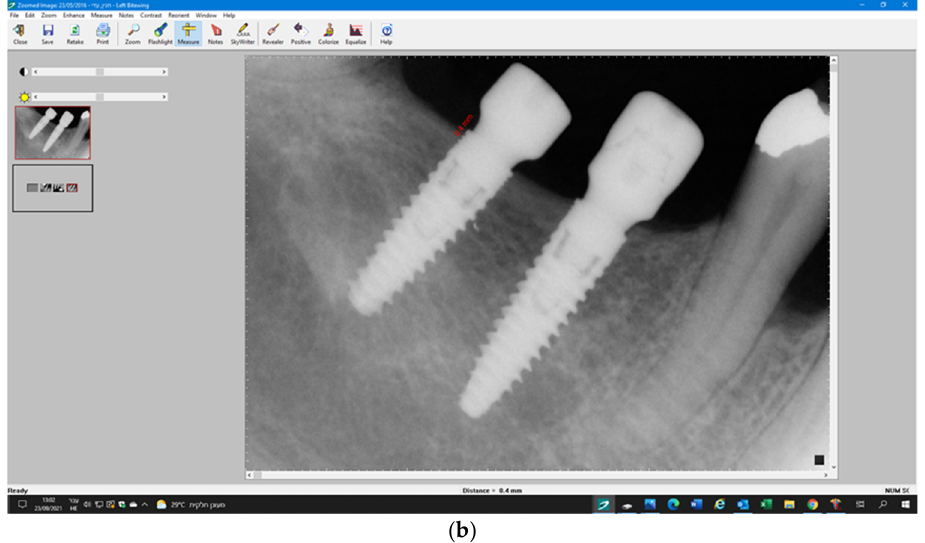
Figure 3. Radiographic measurements. ( a ). Radiographic distortion was calculated by dividing the radiographic implant length by the precise implant length using the measure (line) and calibration function. ( b ). Marginal bone level (MBL) was measured from the first bone-to-implant contact and implant shoulder.